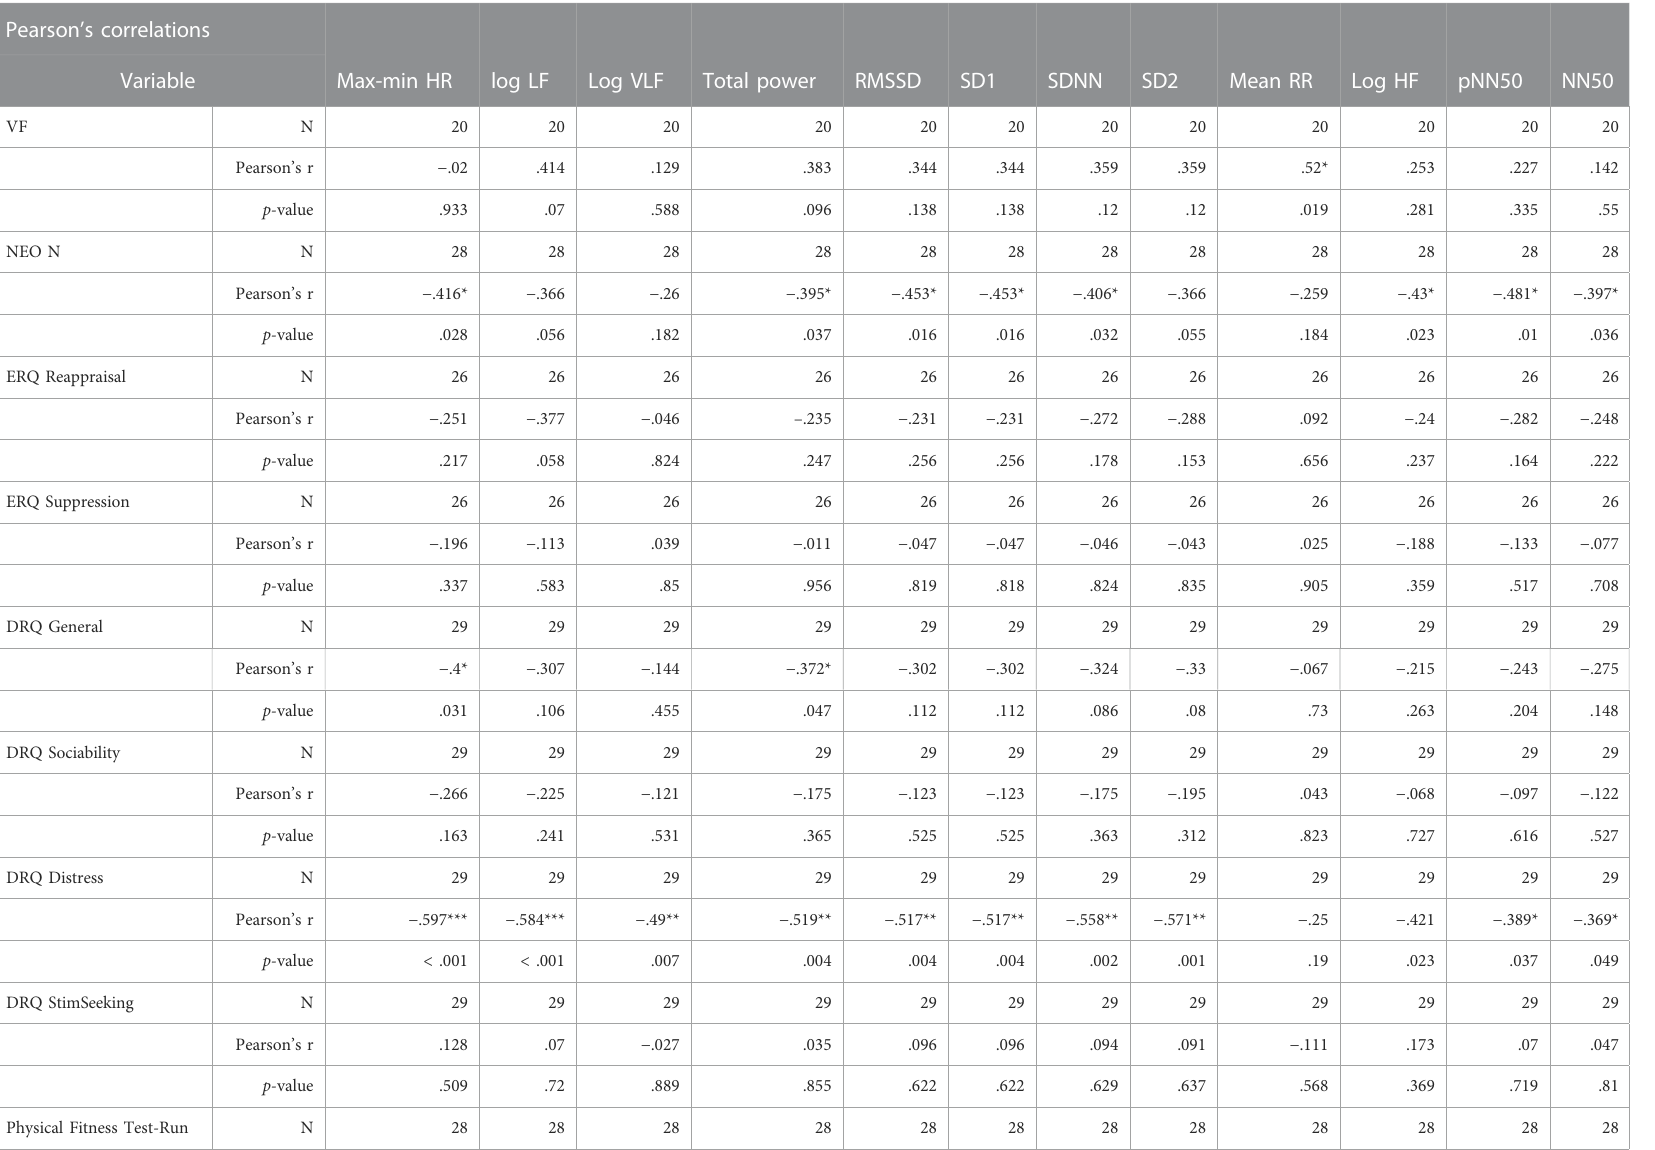
TABLE 2 Correlations between the PNS HR/HRV measures and trait/performance